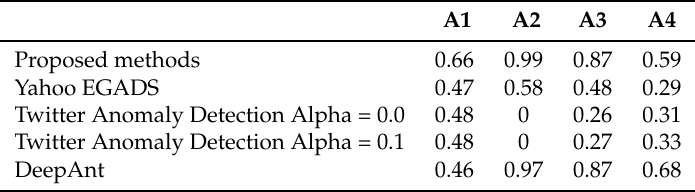
Table 5. Performance comparison of the proposed models with other methods on the whole Yahoo Webscope S5.